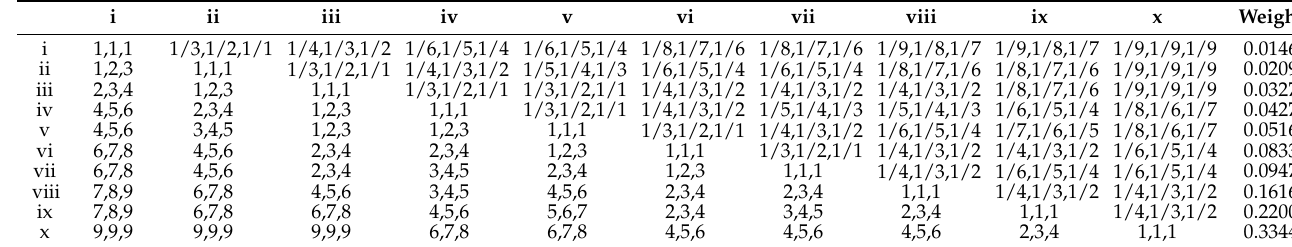
Table 6. Fuzzy-AHP pairwise comparison matrix of landslide conditioning factors and corresponding weights, where i = lithology; ii = aspect; iii = geomorphology; iv = drainage density; v = lineament density; vi = soil type; vii = land use and land cover; viii = profile curvature; ix = rainfall; x =